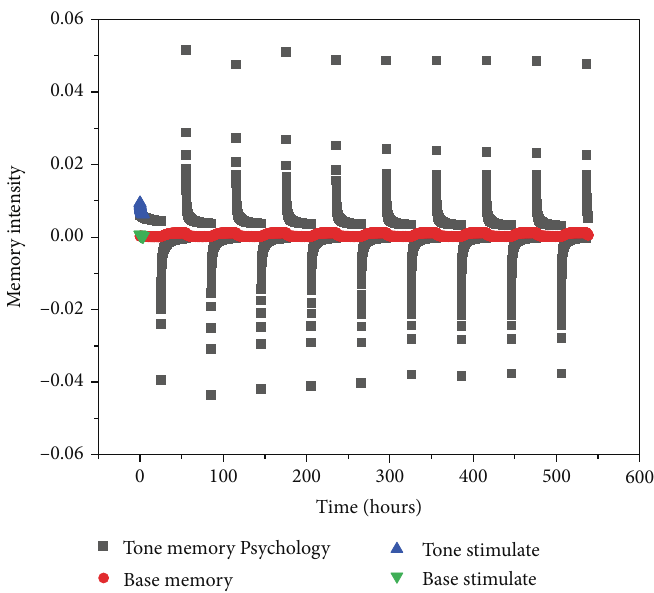
Figure 9: Statistics of memory psychology